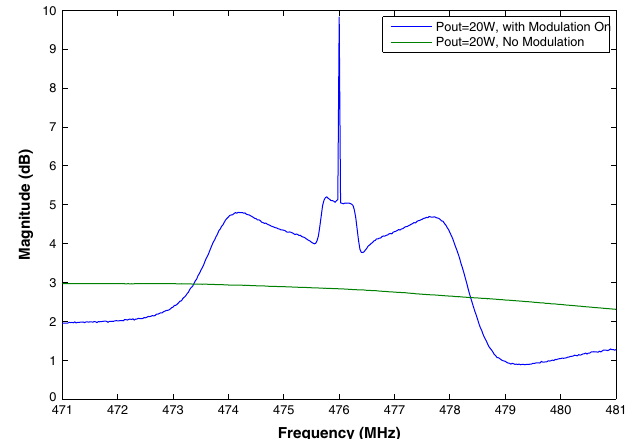
FIG. 21. (Color) Large and small-signal transfer function mea- surement of the original LLRF driver amplifier. The large-signal response is a single swept test frequency, the small signal is a swept signal (cid:2) 30 dB below a fixed 476 MHz carrier.